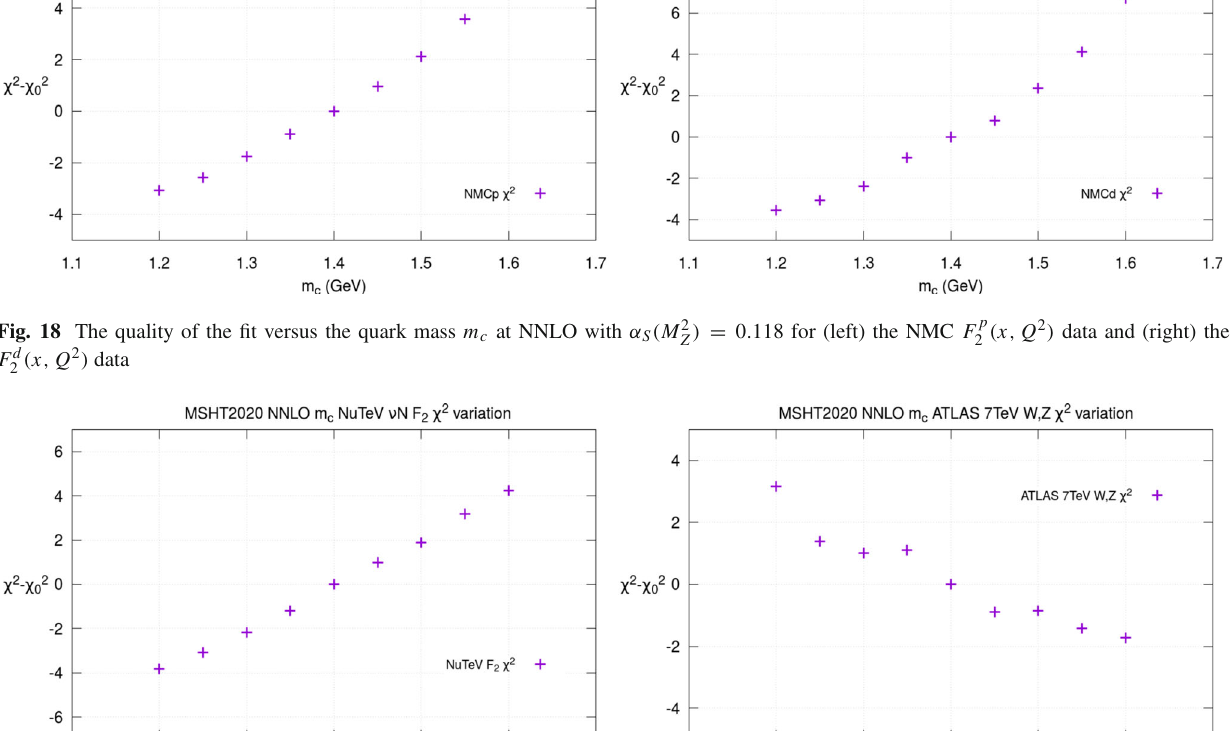
( x , Q 2 ) data and (right) the 2